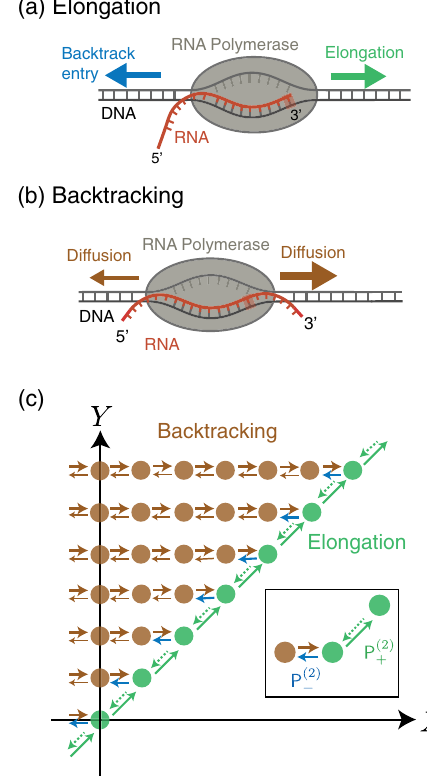
FIG. 12. Stochastic model for transcription. (a) Sketch of an elongating RNA polymerase. The polymerase can either incor- porate a new nucleotide in its active site (red shaded square) or enter a backtracked state. (b) Sketch of a backtracking RNA polymerase. The polymerase diffuses along the DNA template until its active site (red shaded area) aligns with the 3 ’ end of the transcribed RNA. (c) Network representation of a Markov jump process describing the dynamics of RNA polymerases. The X coordinate gives the position of the polymerase along the DNA template, and the Y coordinate gives the number of nucleotides transcribed. Green nodes represent elongating states, and brown nodes represent backtracked states. The inset shows all possible transitions from or to an elongating state. The green solid arrow denotes active translocation of the RNA polymerase, and the dashed green arrow denotes its time-reversed transition. Because the heat dissipated during the forward translocation is much T larger than k , the rate of the backward transition is very B env small. The blue arrow corresponds to the entry in a backtracked state, and the brown arrow is the exit from a backtracked state into the elongating state. In the backtracked state, motion is biased towards the elongating